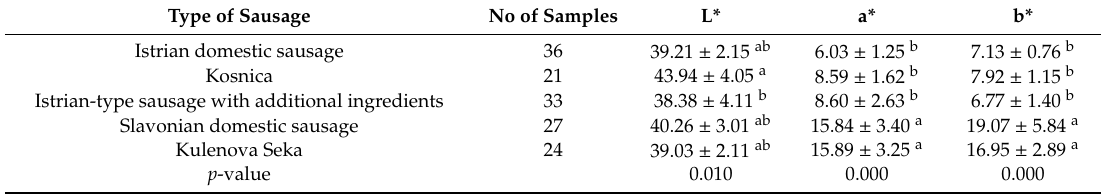
Table 3. Color (L* a* b* values) of Croatian traditional dry-fermented sausages. Type of Sausage